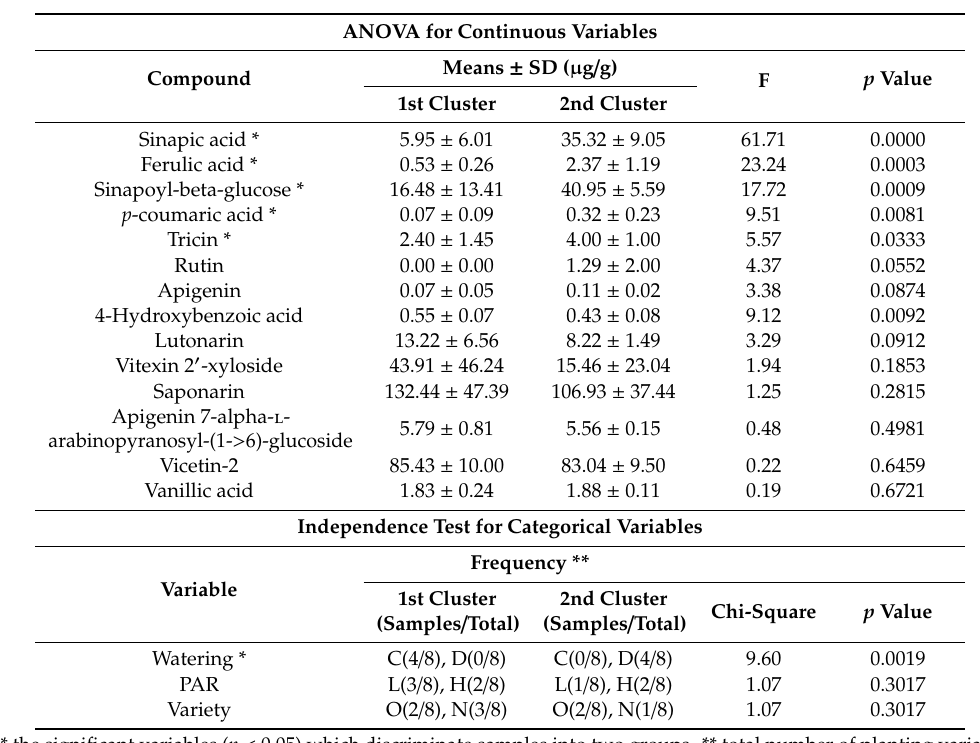
Table 7. Results of k-means clustering algorithm, the number of clusters was determined automatically from the data by using the V-fold cross-validation